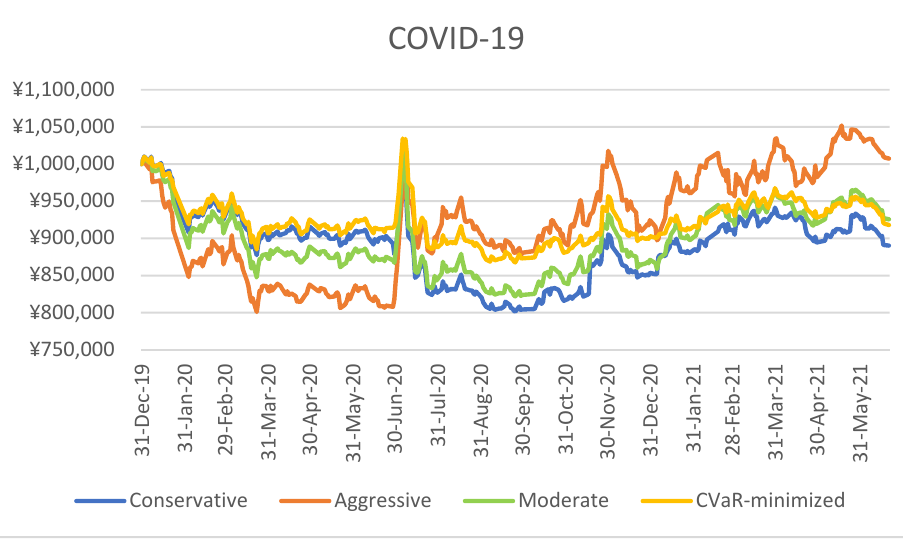
Figure 5. Cumulative gains from four investment schemes in the COVID-19 period.